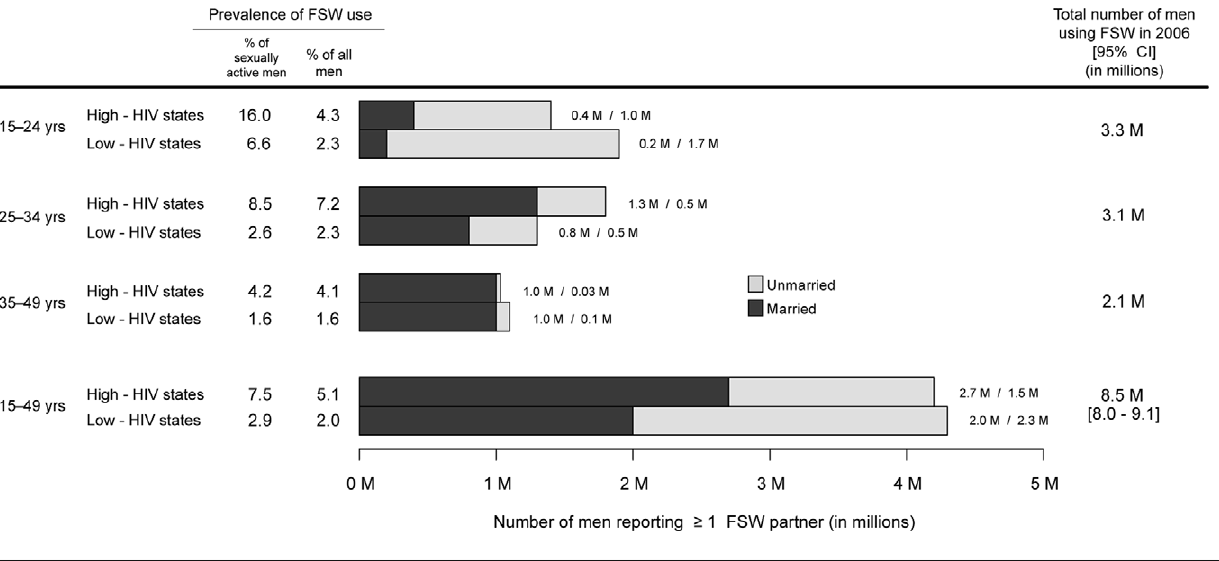
Figure 1. Adjusted prevalence ratios (95% CI) for use of female sex workers (FSW) comparing men with multiple non-regular partners (NRP) to men with one NRP in the past year in 2006. CI=confidence interval. All prevalence ratios (PR) are adjusted for age and education. PR for unmarried men in the high-HIV states is also adjusted for urban residency, employment in the transport sector, having heard of STI, receiving interpersonal STI/HIV/AIDS education in the past year, genital discharge or ulcer in the past year, and consistency of condom use with NRP in the past year. PR for married men in the high-HIV states is also adjusted for urban residency, employment in the transport sector, having heard of STI, receiving interpersonal STI/HIV/AIDS education in the past year, and consistency of condom use with NRP in the past year. PR for unmarried men in the low-HIV states is also adjusted for urban residency, employment in the transport sector, genital discharge or ulcer in the past year, and consistency of condom use with NRP in the past year. PR for married men in the low-HIV states is also adjusted for employment in the transport sector, awareness of a local HIV test centre, and consistency of condom use with NRP in the past year.